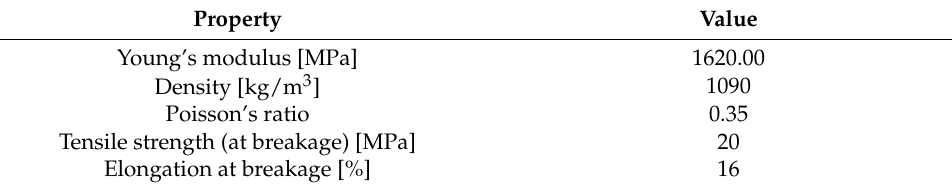
Table 2. Mechanical properties of polypropylene [17].